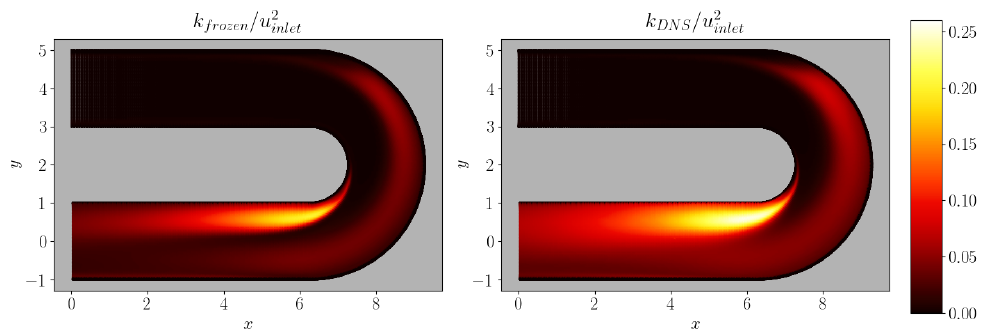
Figure 9. Comparison between DNS and frozen k